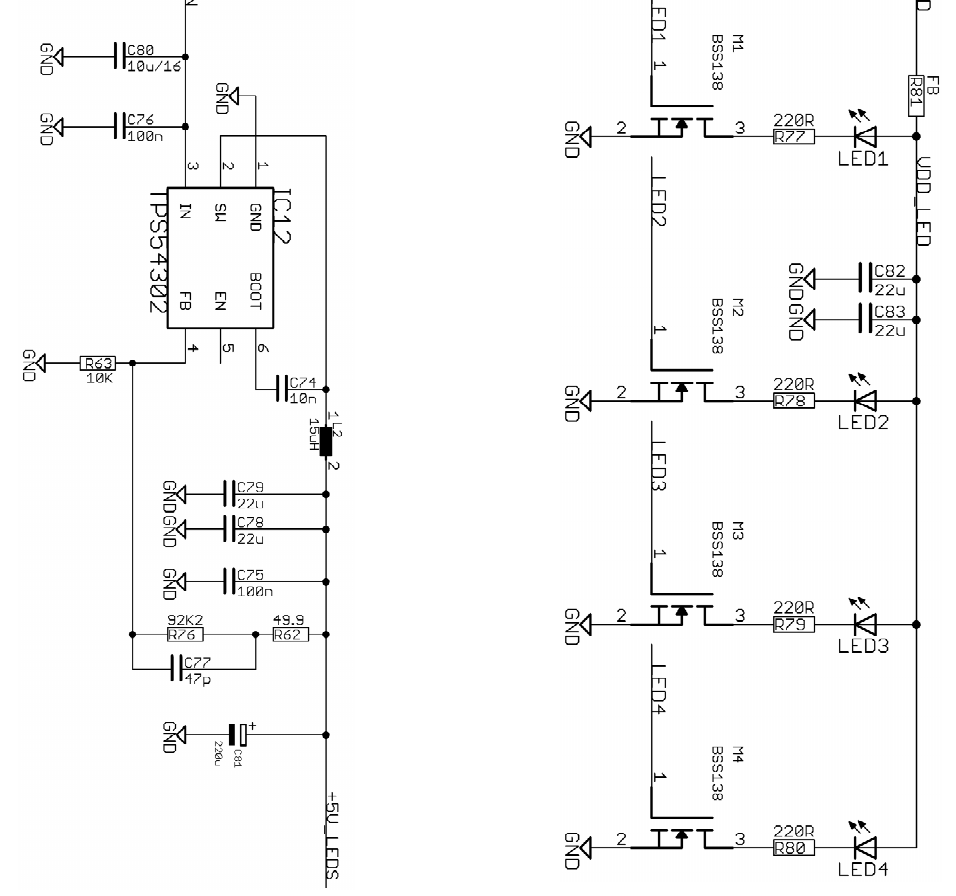
Figure A7. ( left ) Sensor LEDs’ power supply. ( right ) Indicator LEDs. The LED arrays are powered with 5 V. The SMPS TPS54302 (IC12) produces this voltage. The indicator LEDs are controlled by the CPU through the MOSFETs M1, M2, M3, and M4.